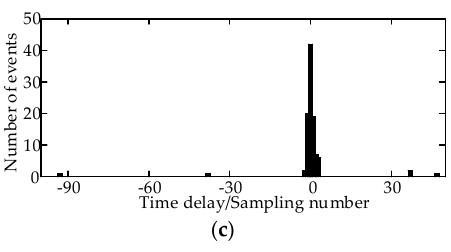
Figure 5. The original and noisy ultra-high frequency (UHF) signals radiated by P 2 at O 2 and the calculated TDs. ( a ) The received UHF signals radiated by P 2 at O 2 ; ( b ) The noisy UHF signals when the signal-to-noise ratio (SNR) = 5 dB; ( c ) The calculated TDs. The 300 TDs corresponding to three PDs with each rotating angle were obtained. Taking